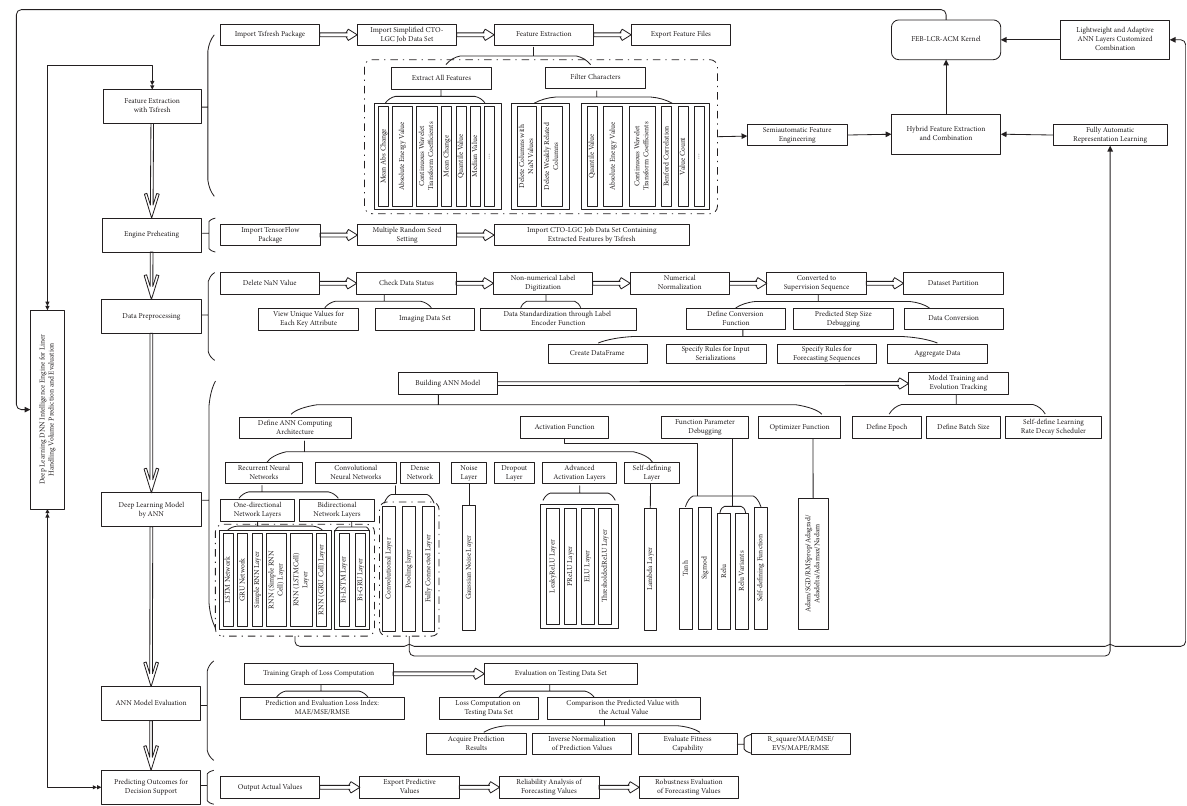
Figure 2: Problem-oriented lightweight adaptive deep learning model for